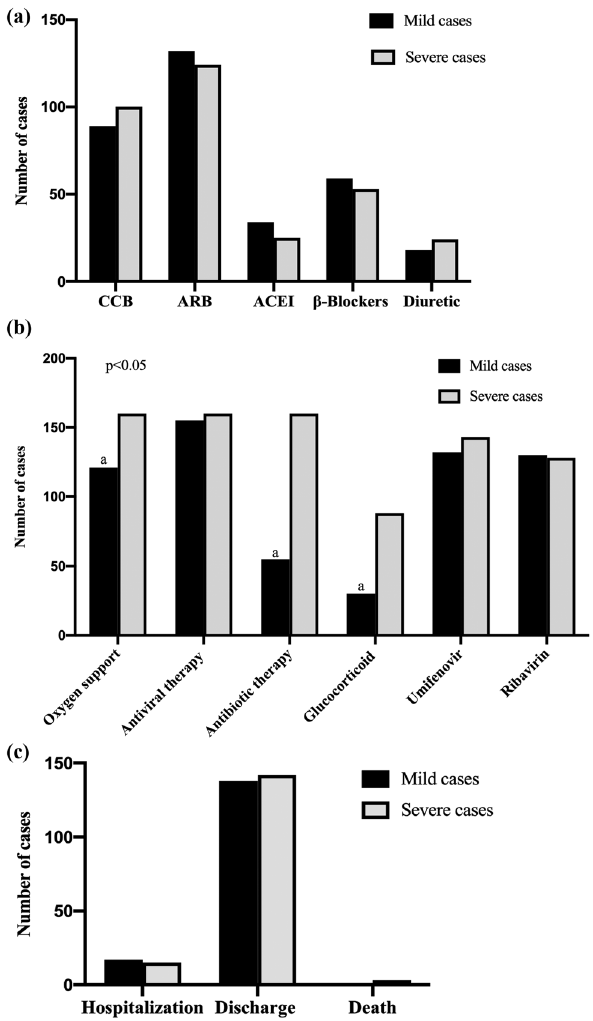
Figure 3: The treatment and outcomes of hypertensive patients with COVID - 19. ( a ) Antihypertensive used in hypertensive patients with COVID - 19. ( b ) General treatment used in hypertensive patients with COVID - 19. ( c ) The outcomes of hypertensive patients with COVID - 19. a P values indicate di ff erences between the mild and severe hyper - tensive patients. P < 0.05 was considered statistically signi fi